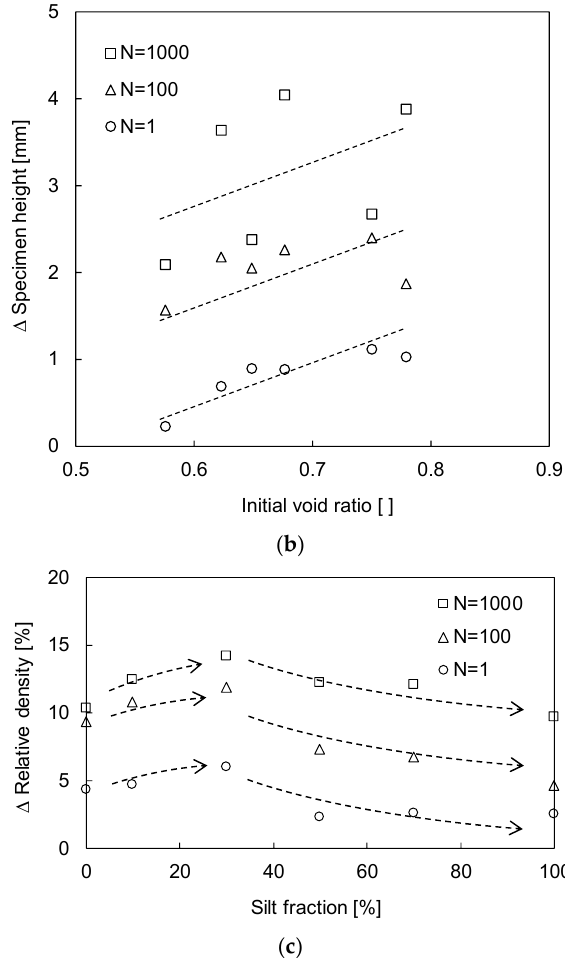
Figure 5. Volumetric change in sand–silt mixtures subjected to N = 1, 100, and 1000: ( a ) ∆ Specimen height according to SF; ( b ) ∆ Specimen height according to initial void ratio; ( c ) ∆ D r according to SF.